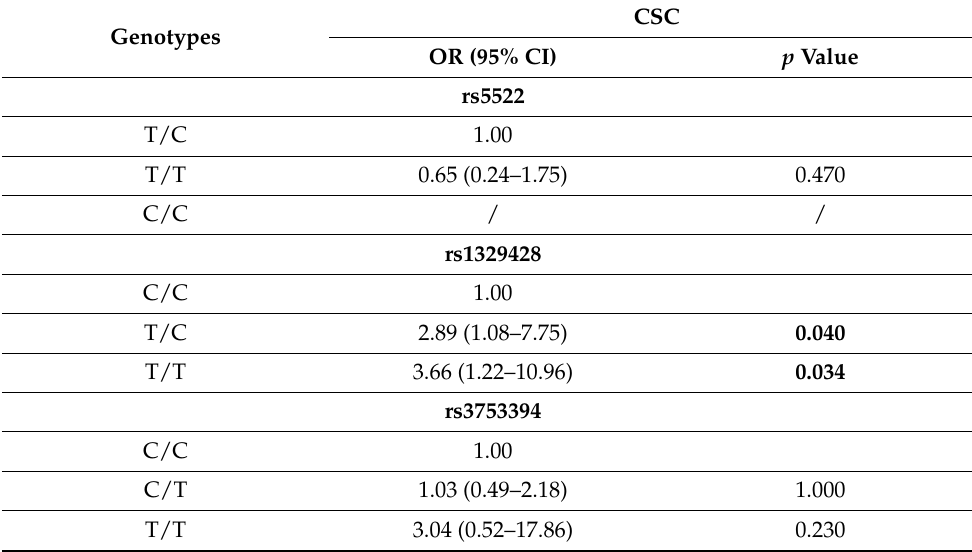
Table 4. Odds ratio (OR) calculations for the investigated single nucleotide polymorphisms (SNPs). CSC: central serous chorioretinopathy; OR: odds ratio. Bold font indicates data considered to be statistically significant ( p <